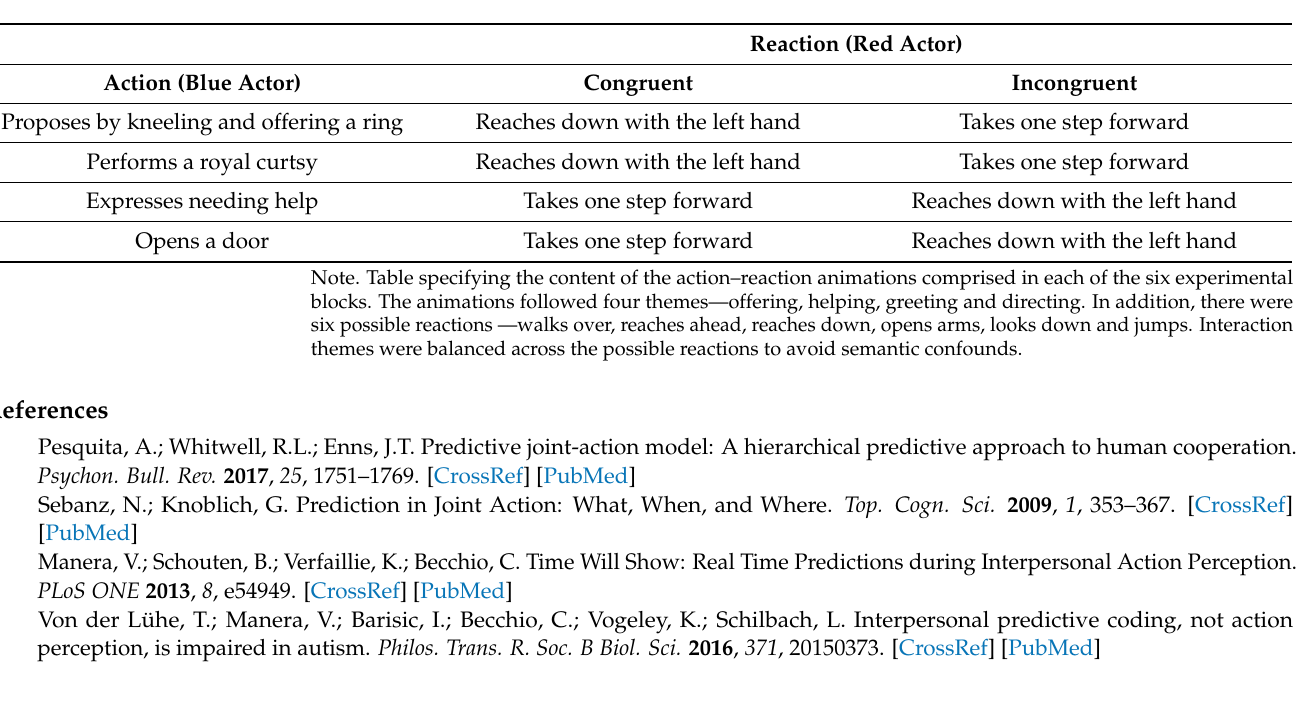
Table A6. Action–reaction sequences in Block